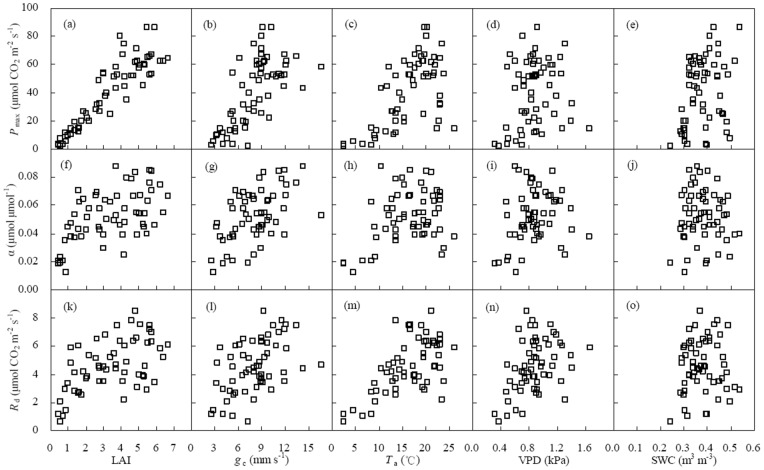
Effects of biophysical factors (g
c, LAI, T
a, VPD and SWC) on light response parameters (α, P
max and R
d) at 5-day intervals during the main growing season of winter wheat.The meanings of abbreviates were the same as those in Figures 3 and 4.